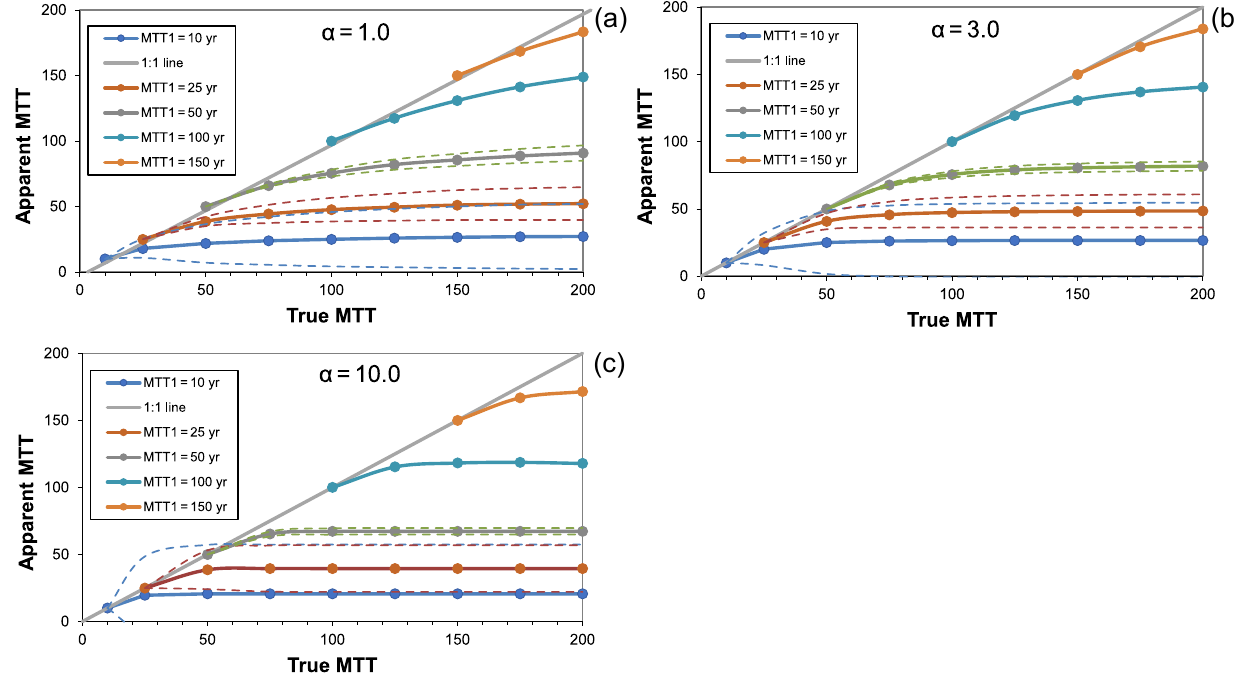
Figure 6. Aggregation effects for tritium MTTs using the Trier input function. Symbols as in Fig.